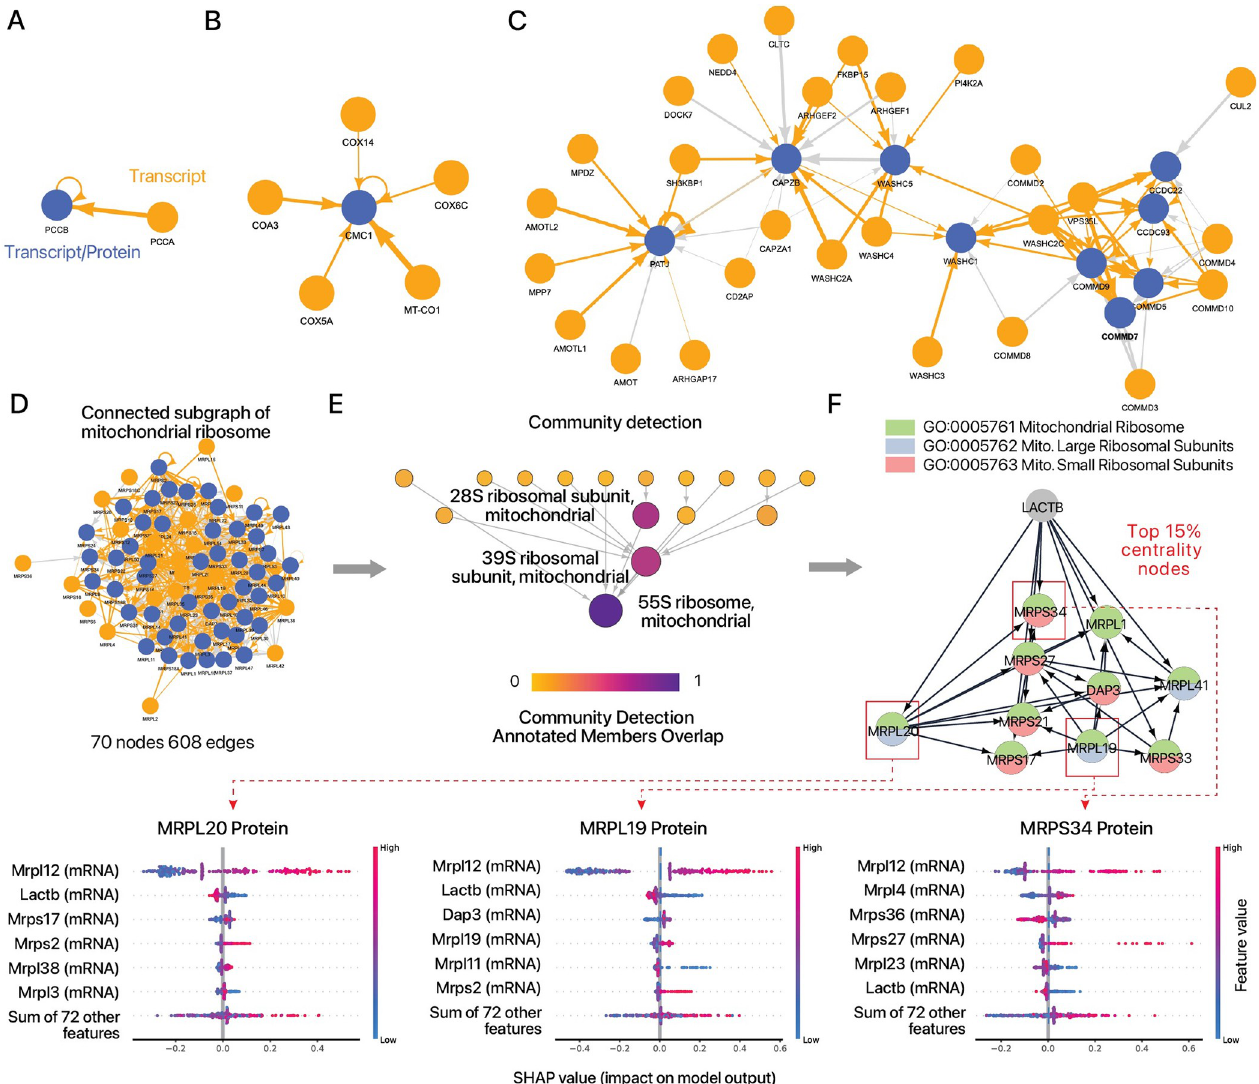
Fig 6. Directed graphs of protein and transcript interrelationships identify candidate regulatory genes. A-C. Examples of directed graphs constructed from genome-wide relationships of transcript-predicted proteins, containing members of A. the propionyl-CoA carboxylase complex; B. the cytochrome c oxidase, mitochondrial complex; C. the PI4K2A-WASH complex, the RICH1/AMOT polarity complex, and others. In each subgraph, orange nodes have outflow edges only (i.e., they are contributing transcripts in the prediction models). Blue nodes are nodes that are connected to other nodes via at least one inflow edge (i.e., they represent proteins, and optionally also transcripts if they also have outward edges). Orange edges represent positive coefficients of the transcripts to the target proteins in the elastic net models; gray edges represent negative coefficients. All edges are directed from transcript to protein, and the widths of the edges are scaled by the weight. D. A highly connected subgraph of mitochondrial ribosome subunits containing 73 nodes and 834 edges. E. Persistent community detection and network representation of preferential node connections, showing a hierarchical relationship between the 28S and 39S subcomplex with the assembled 55S mitochondrial ribosome. F. Network representation of hub nodes defined as 15% of nodes ranked by betweenness centrality, which predicts a potential role of LACTB as a critical hub that lies upstream of multiple large and small mitochondrial ribosomal protein subunits. Node colors represent the pie chart diagram of the corresponding GO biological process described in the table. SHAP values of three proteins (MRPL20, MRPL19, MRPS34) are highlighted showing top model contributors.